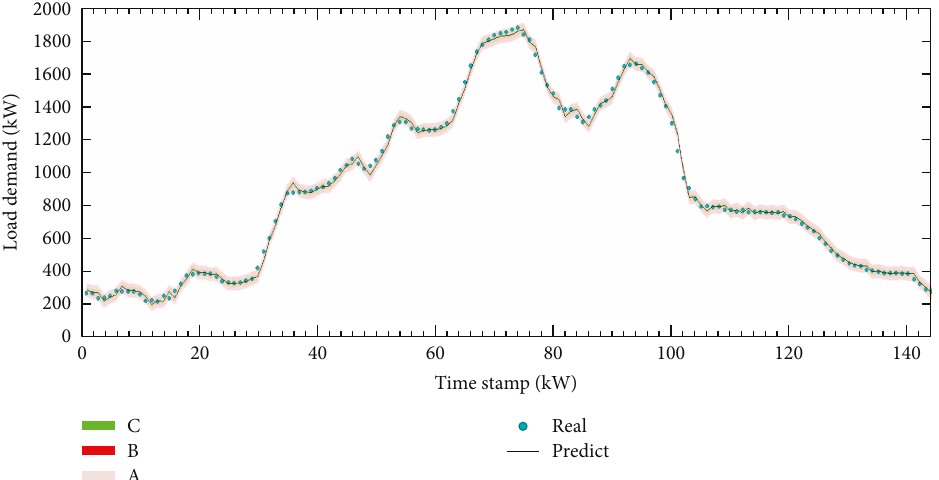
Figure 10: Fuzzy Interval prediction for one day ahead (case 1) load power with coverage